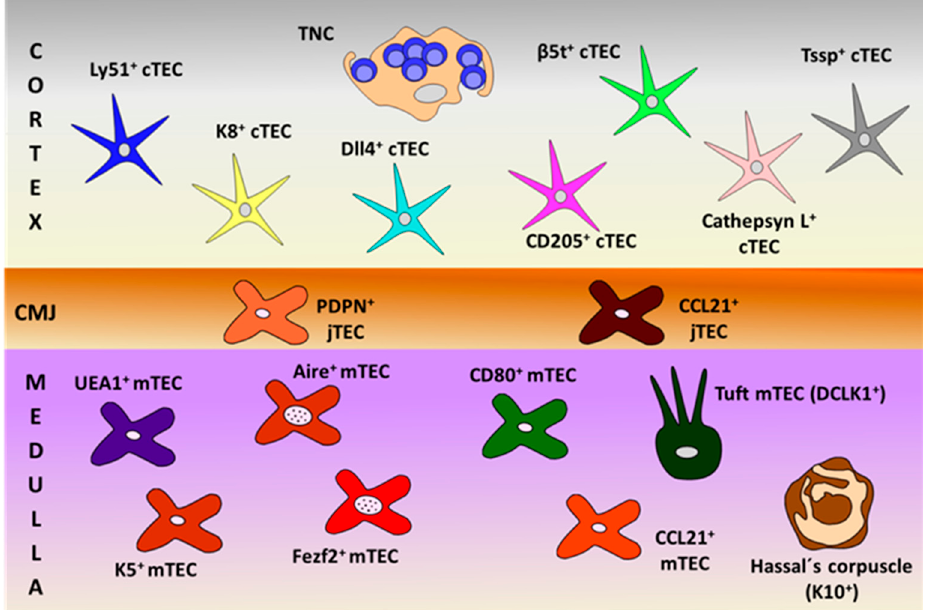
Figure 1. Schematic representation of thymic epithelial cell (TEC) subsets, defined by their specific cell markers in the different thymic compartments (cortex, cortico-medullary junction (CMJ) and medulla). PDPN: podoplanin; TNC: thymic nurse complexes.